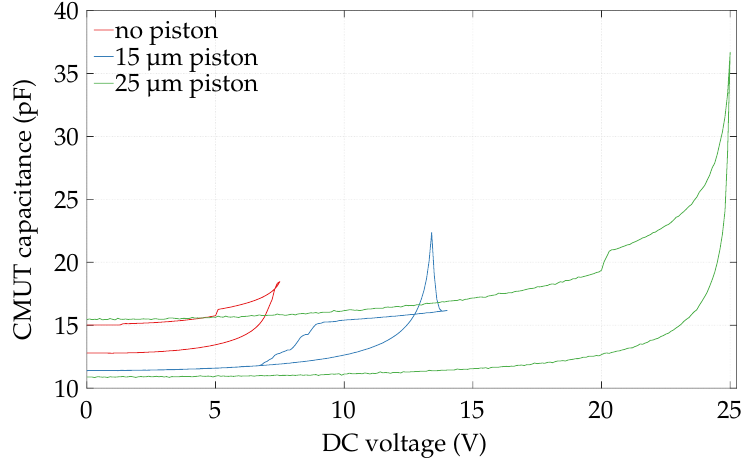
Figure 8. Chip-level measurement of capacitance characteristics in dependence on bias voltage. One element field of 45 plates in parallel is characterized. Measurements show the pull-in voltage and the hysteresis/sticking of the cells of no piston, 15µm, and 25µm wide